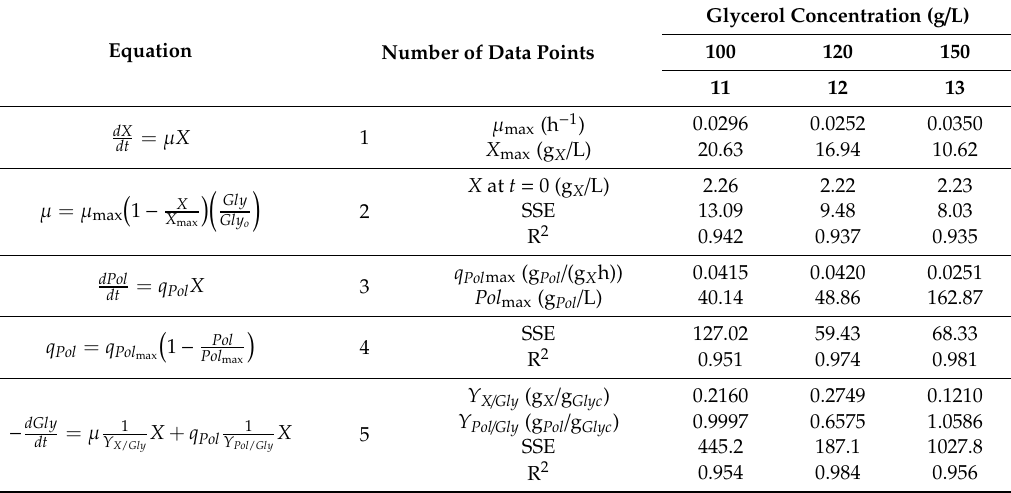
Governing equations and associated kinetic parameters related to biomass growth, glycerol consumption and polyols production during Yarrowia lipolytica culture on di ff erent glycerol